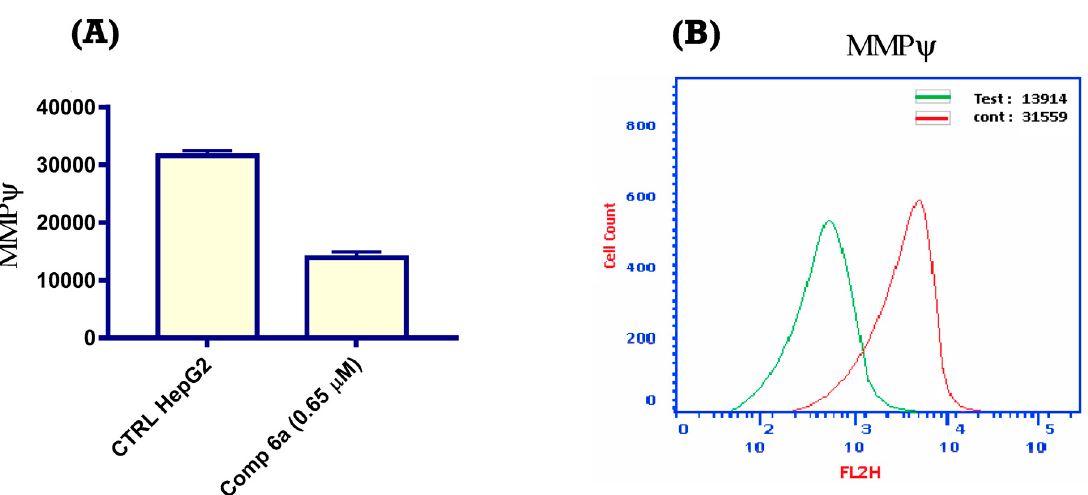
Figure 7. ( A ) Graphical representation of MMP in HepG2 cells after 48 h of compound 6a exposure at its IC 50 concentration ( µ M) compared with the untreated control. ( B ) Cryptogram shows the loss of MMP during compound 6a treatment in in HepG2 cells after 48 h compared with the untreated